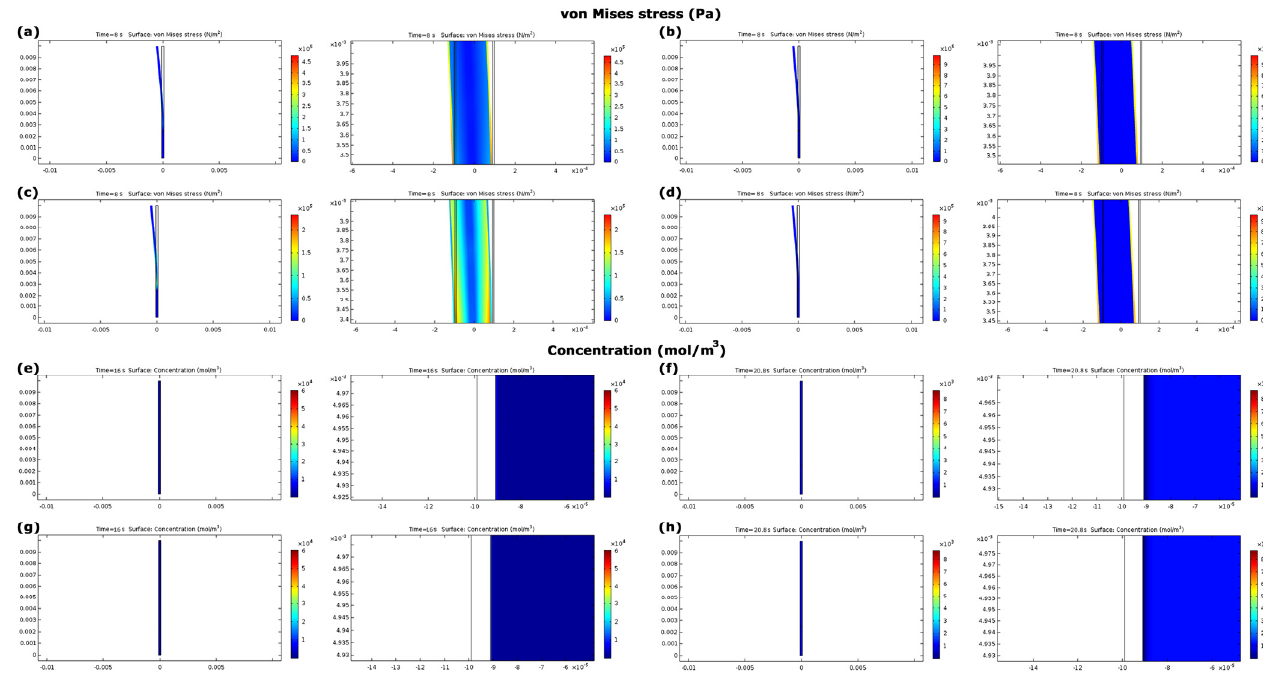
Figure 7. ( a – d ) show the distribution of von Mises stress in IPMC with BSA–CNT, gold, MCC–CNT, and platinum electrodes with their zoom panels, respectively. ( e – h ) show the distributions of cation concentrations in IPMC with BSA–CNT, gold, MCC–CNT, and platinum electrodes with their zoom panels, respectively. The panels are not to scale.